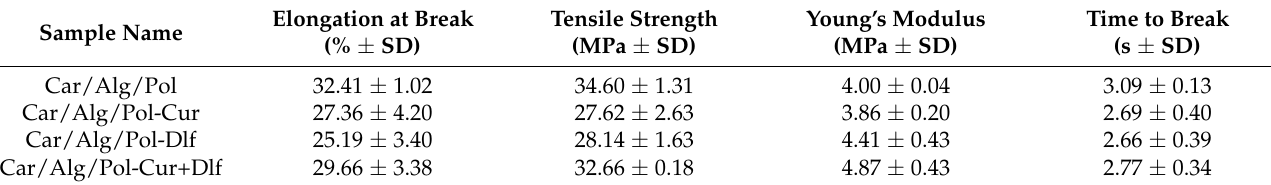
Table 2. The mechanical properties of analyzed films ( n =